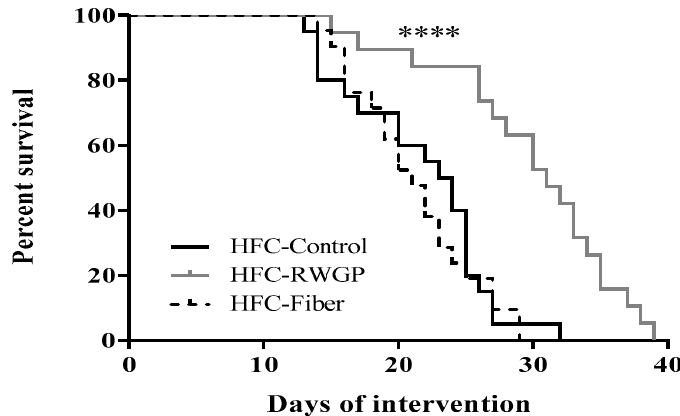
Figure 1. E ff ect of RWGP supplementation on survival of SR-B1 KO / ApoER61 h / h mice fed atherogenic diet. Kaplan–Meier survival curves of HFC-Control ( n = 20), HFC-RWGP ( n = 19), and HFC-Fiber ( n = 21) groups obtained from three independent experiments. **** indicates p < 0.0001 between HFC-RWGP vs. HFC-Control and HFC-Fiber groups based on log-rank test.